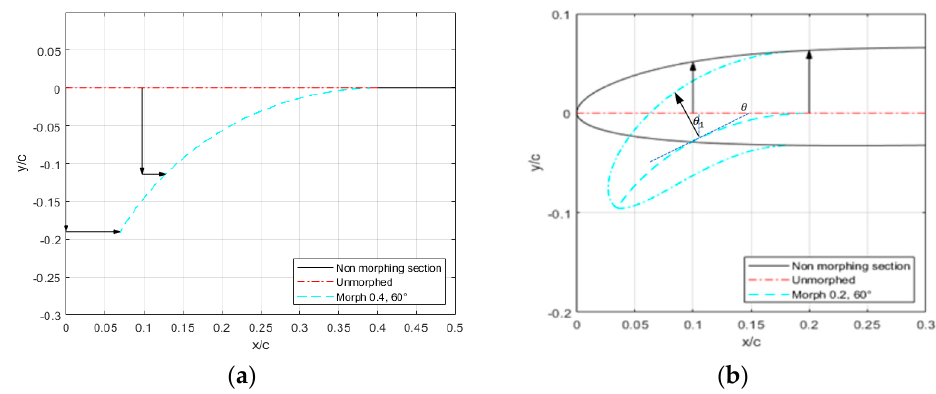
Figure 7. Translation from the deflection arc ( a ) and relative skin position to the deflection arc ( b ).